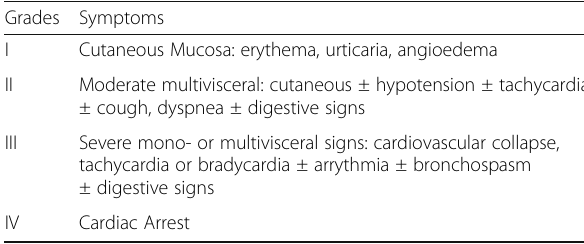
Table 2 Symptoms based on the Ring and